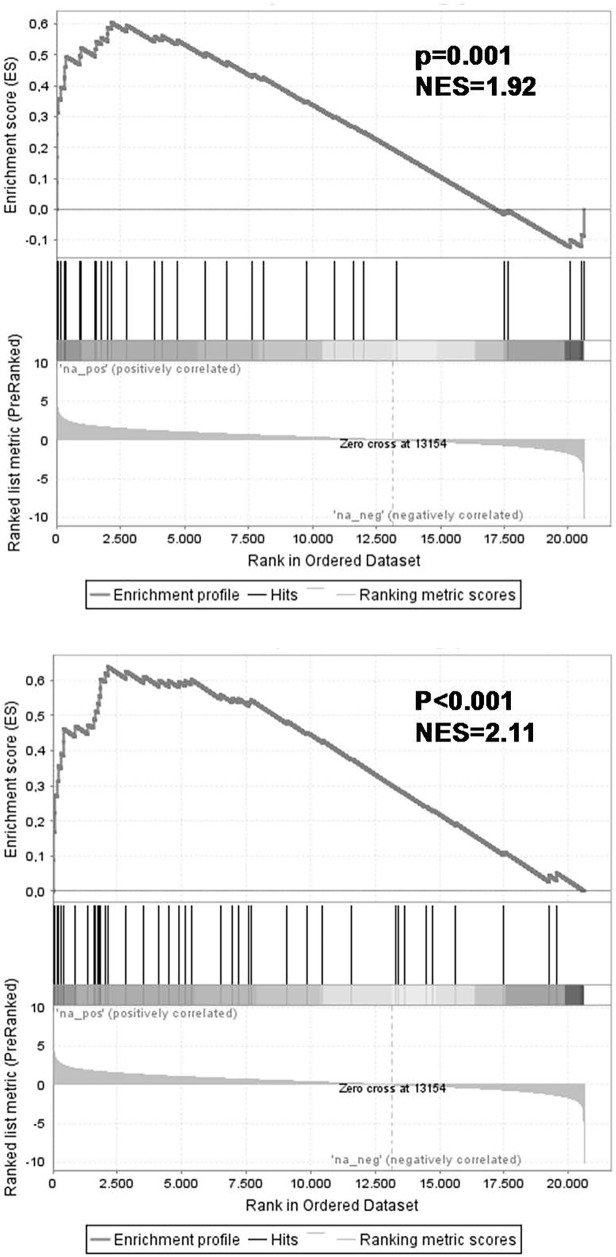
Genes responsive to the repression of MLL-ENL and MLL-AF4 often represent known MLL-AF4 target genes.Gene set enrichment analysis (GSEA) of the 56 differentially expressed probe sets recurrently affected in both KOPN-8, RS4;11, and SEMK2 cells upon MLL fusion knock-down in gene lists consisting of MLL-AF4 target genes as published by Guenther et al. (8) (left) and Krivtsov et al. (7) (right). NES = normalized enrichment score.